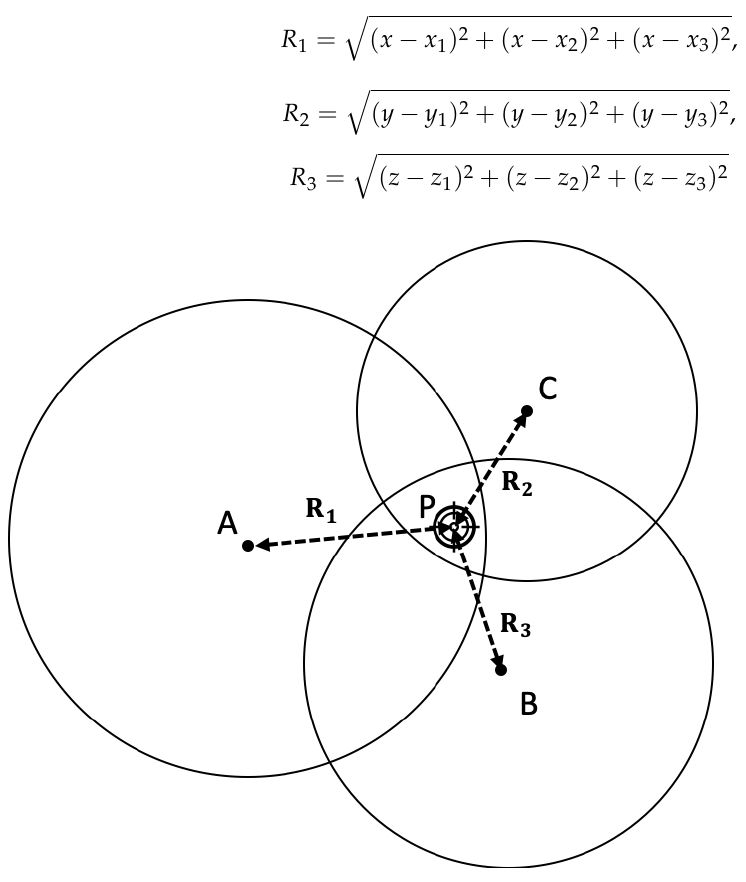
Figure 3. TOA—based distance